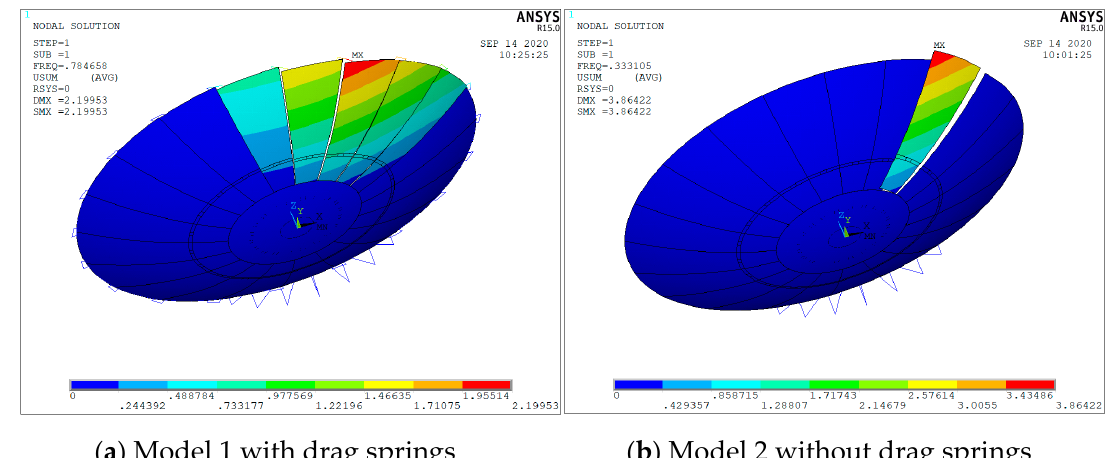
Figure 8. First order mode shapes of Model 1 and 2 in 3D visualization.